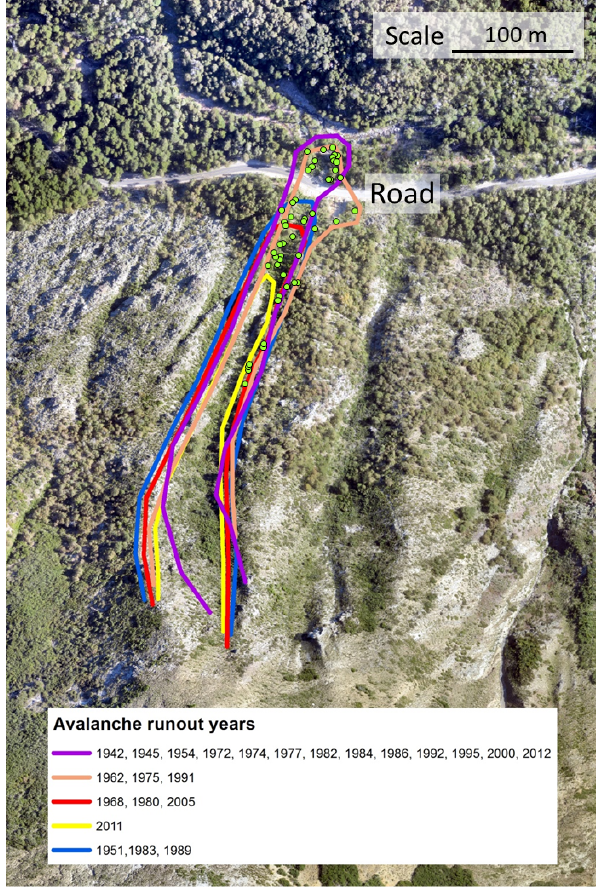
Figure 6. Reconstructed borders and runouts at avalanche track 6 using tree-ring data from the first registered event in 1942 up to the sampling time in 2015. The green circles indicate sampled